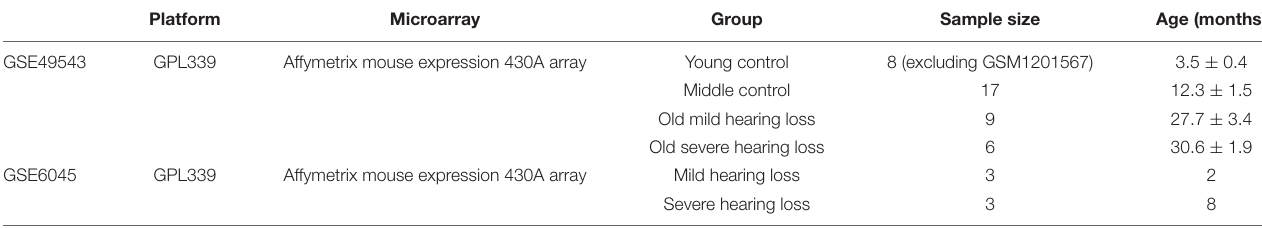
TABLE 1 | Details and characteristics of mice in the two datasets (GSE49543 and GSE6045). Platform